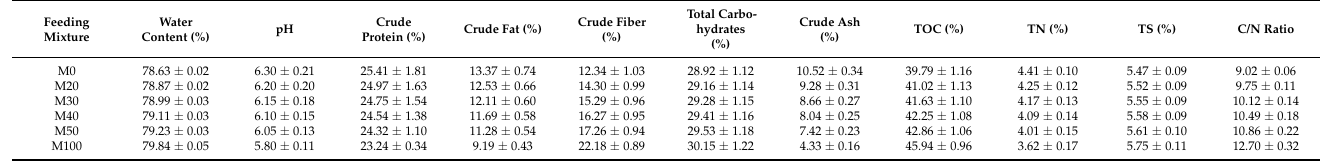
Table 2. Nutritional constituents of mixed organics between SCR and